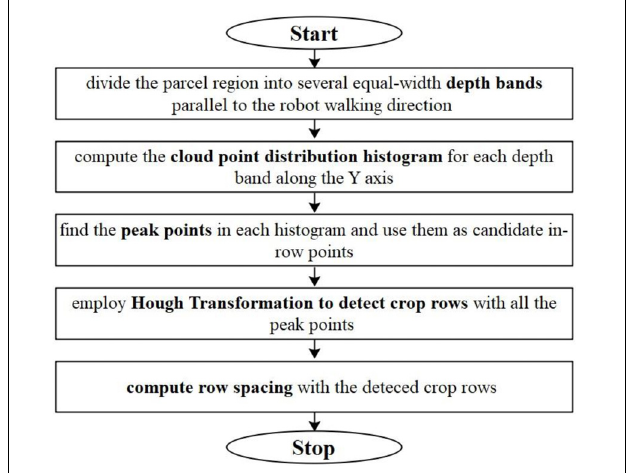
FIGURE 9 | Flowchart for row spacing computation.